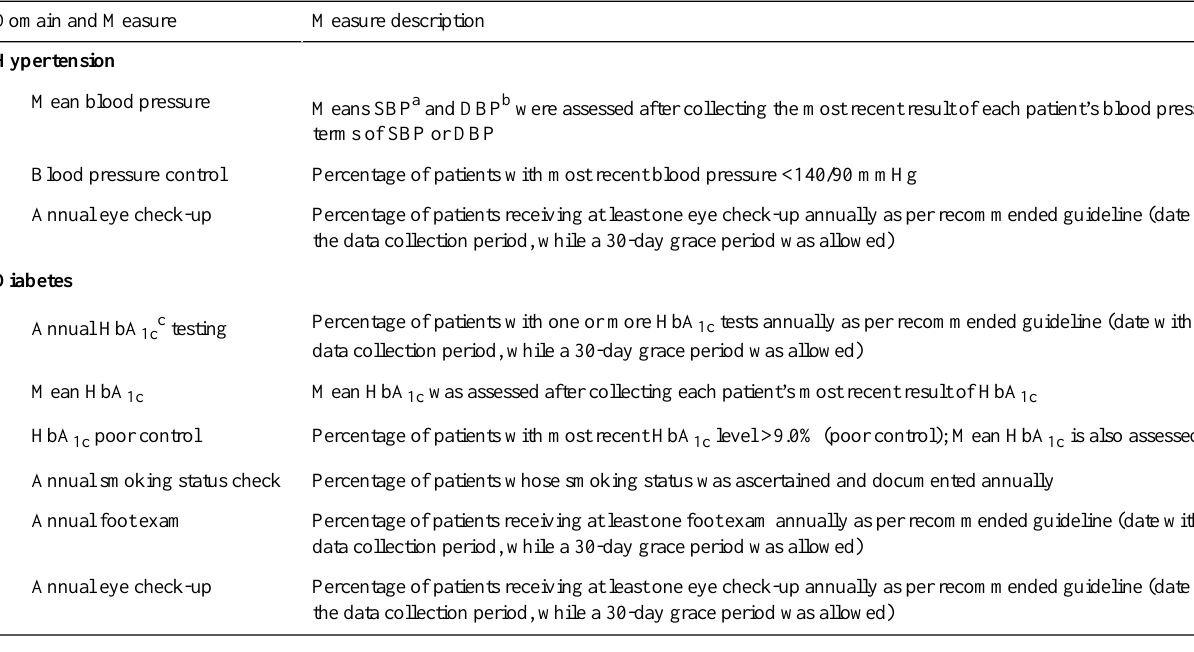
Table 1. Selected quality indicators to monitor the effectiveness of the